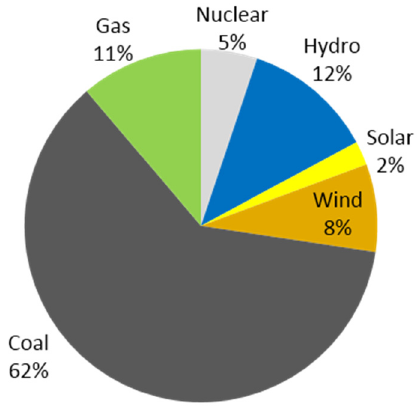
Figure 5. Total primary energy consumption of China in the Reference Scenario.